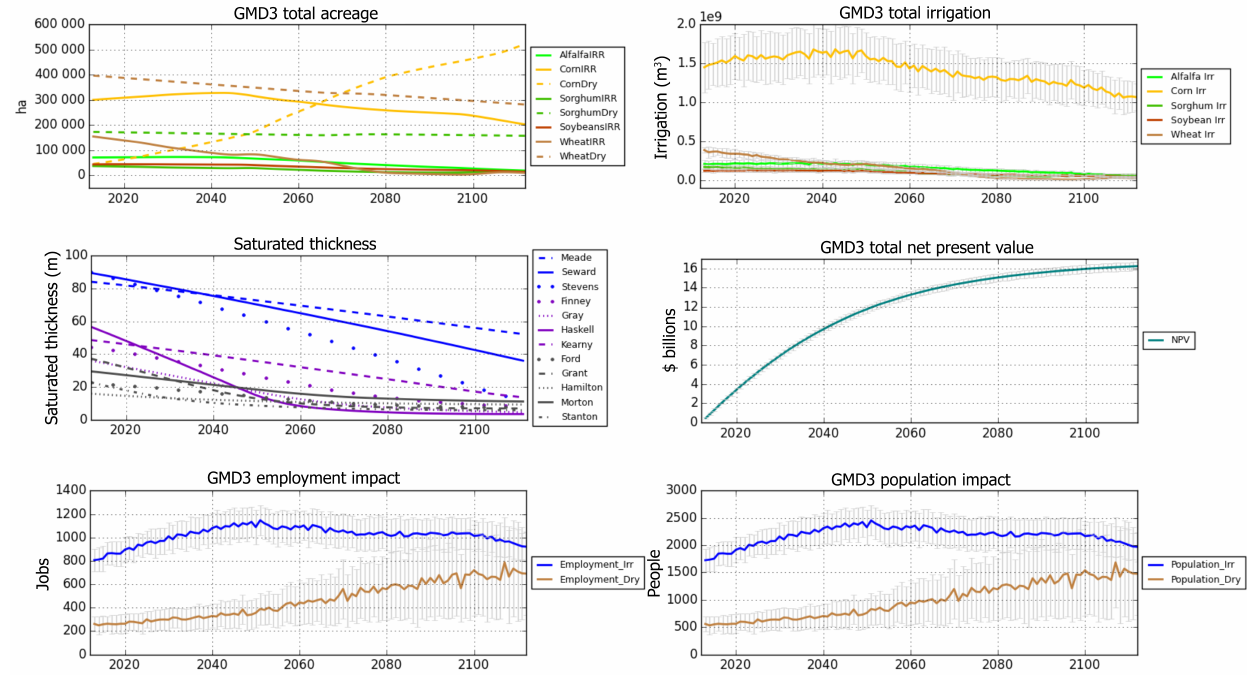
Figure 3. Baseline outcomes of current irrigation practices in GMD3: 100 simulations. Top row panels: the left graph shows the acreage planted for dryland and irrigated crop varieties. Note the demise of irrigated corn and the rise of dryland corn over the course of the simulation. The right graph depicts total water consumed in GMD3 by each irrigated crop. Middle row panels: the left graph shows the average level of saturated thickness of the Ogallala in each of the 12 counties over time. Note that only two of the 12 counties end the simulation with an average saturated thickness greater than 15m, 6 have averages less than 9m. Generally, more than 9m of saturated thickness is needed to irrigate using center pivots. The right graph sums the NPV across all 12 counties over time. Bottom row panels: the left graph illustrates the predicted number of additional jobs created in a simulated year due to the direct, indirect, and induced impacts of irrigation and dryland crop production, respectively. Note that over time, the level of variation in employment due to dryland crop production is exceptionally large, reflecting the greater levels of uncertainty introduced by a gradually warmer climate. The graph on the right depicts the number of additional people who live in the GMD3 in that year because of irrigated and dryland crop production. The population impact mirrors the level of variation shown in the previous graph. The whiskers denoting the level of uncertainty (2 σ ) are excluded on the top two graphs on the right to maintain the clarity of